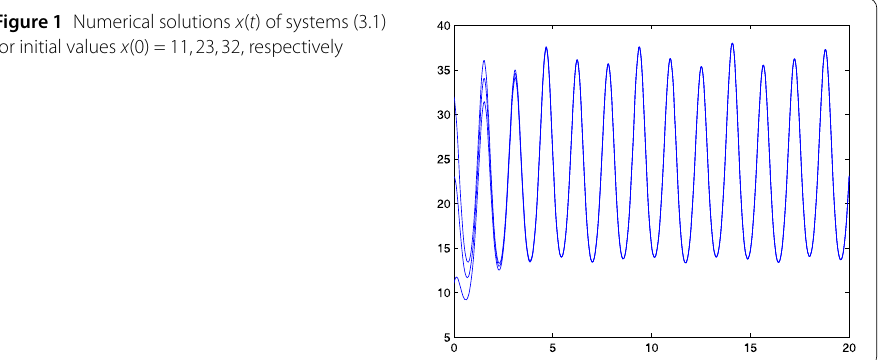
Figure 1 Numerical solutions x ( t ) of systems (3.1) for initial values x (0) = 11,23,32,